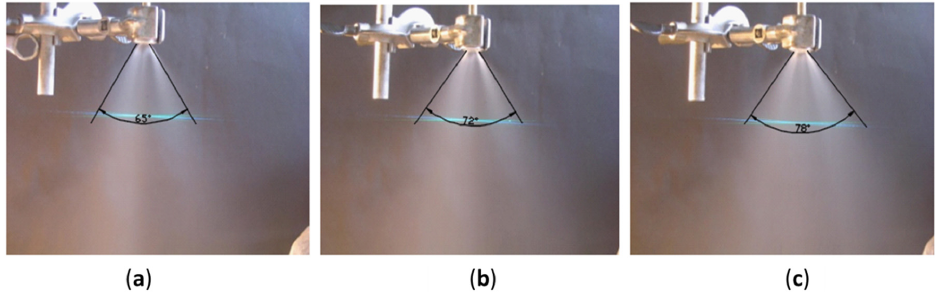
Figure 8. Volume flux vs radius for different water pressure.